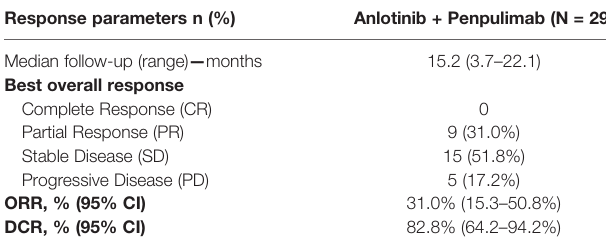
TABLE 1 | Baseline clinical characteristics. TABLE 2 | Responses to study medication (n =